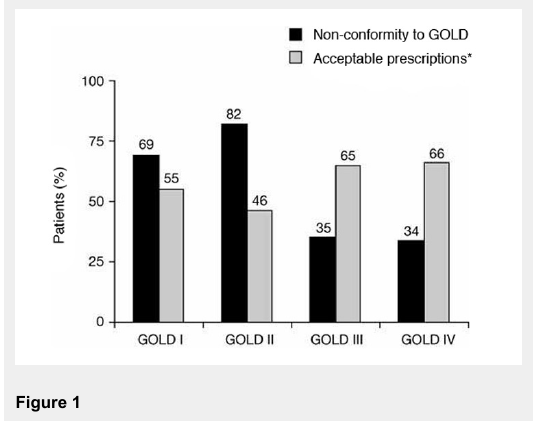
Non-conformity to GOLD guidelines. Abbreviations: GOLD: Global Initiative for Chronic Obstructive Lung Diseases; ICS: inhaled corticosteroid. * Considering ICS prescription for co-morbid asthma